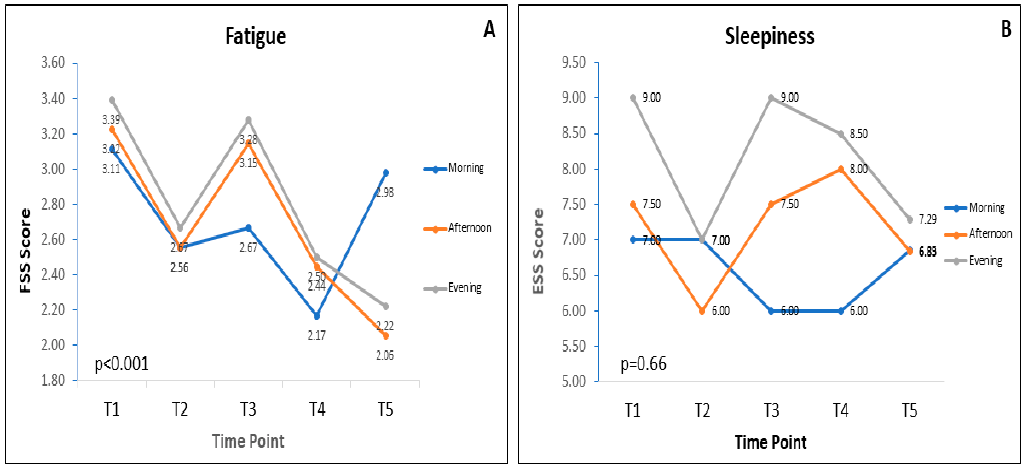
Figure 2. Patterns of fatigue ( A ) and sleepiness ( B ) scores during RF at T1 (one week before RF; n = 34), T2 (mid of RF; n = 34), T3 (last days of RF; n = 34), T4 (one week after RF; n = 34) and T5 (one month after RF; n = 34). Both fatigue and sleepiness were assessed in the morning, afternoon and evening. Data presented as median.